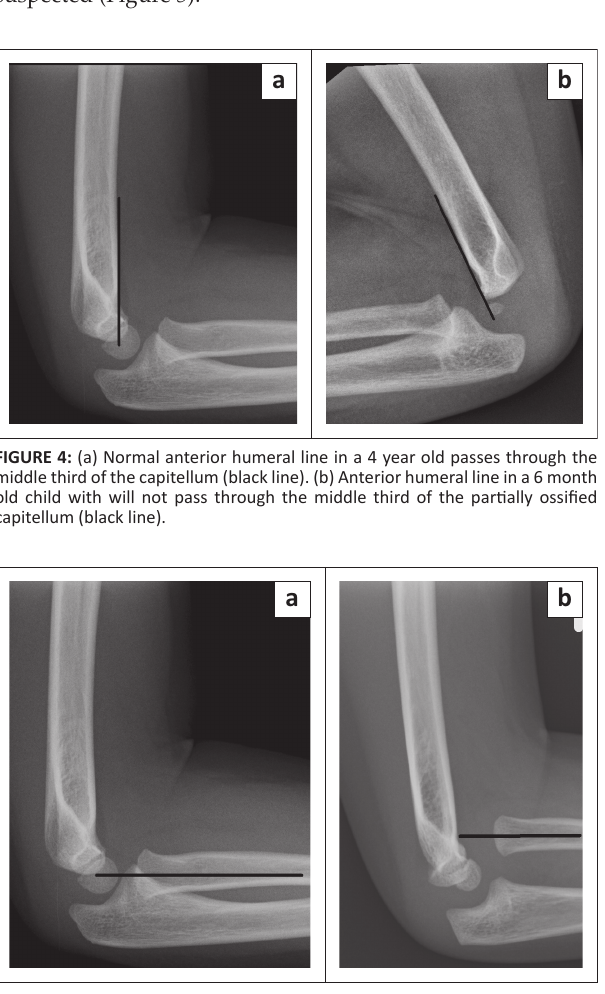
FIGURE 5: (a) Normal radiocapitellar line (black line). (b) Displaced radiocapitellar line that does not intersect the capitellum in radial dislocation (black